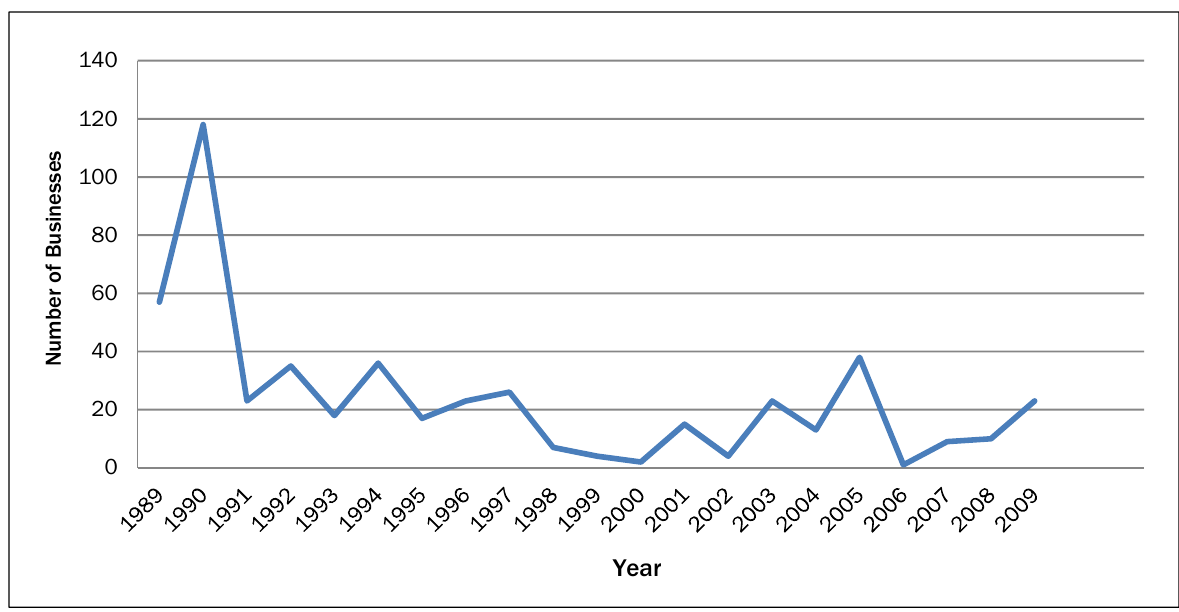
Figure 1. Number of U.S. Farmworkers Who Own or Are Buying a Business by Year, 1989–2009